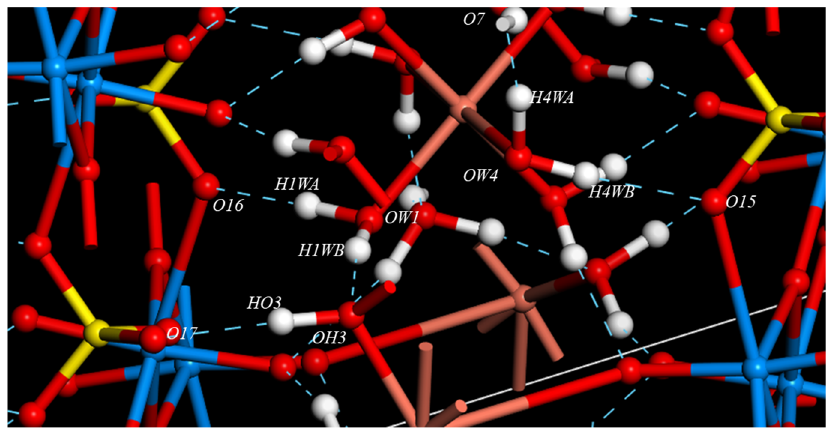
Figure 6. Hydrogen bonding structure in the crystal structure of pseudojohannite. Hydrogen bonds donated by OW1 and OW4 and OH3. Table 3. Hydrogen bond parameters in pseudojohannite (distances are given in Å and angles in degrees).